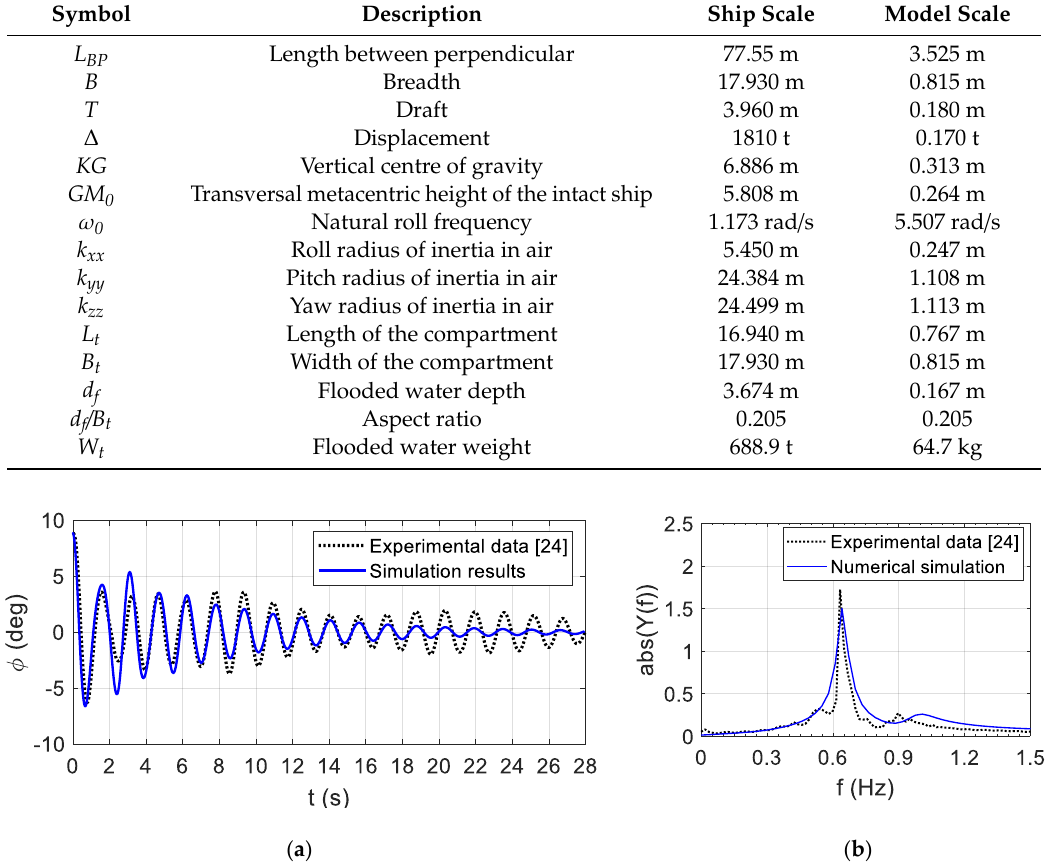
Figure 8. Roll decay ( a ) and FFT analysis ( b ), both referring to the model scale.